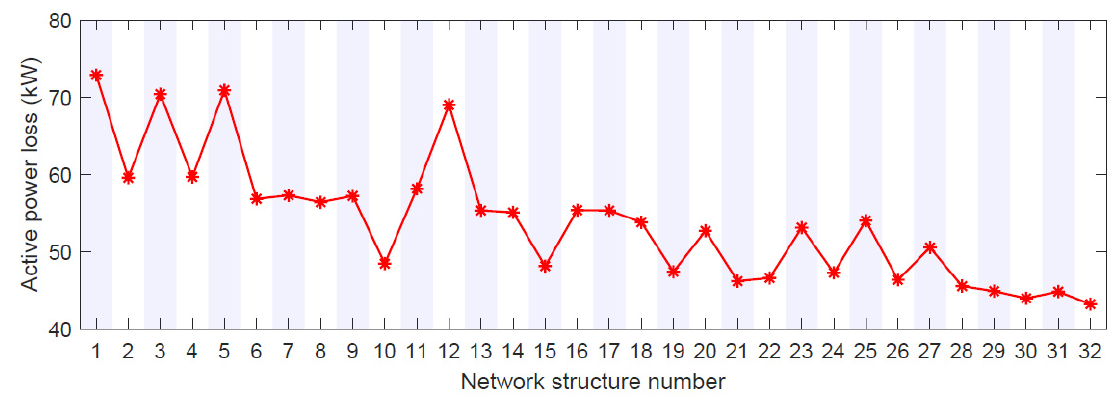
Figure 11. Variation of the active power loss of all the network structures.